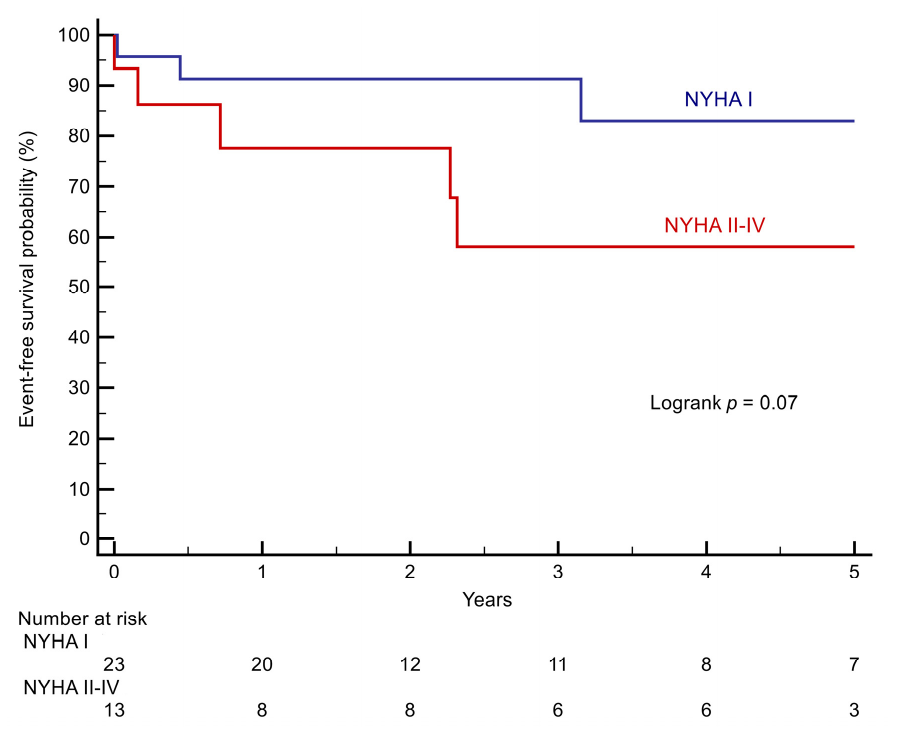
Figure 1. Kaplan–Meier curves stratifying patients according to NYHA class. The difference between patients with corrected vs. uncorrected cAVSD was not sta- tistically significant ( p = 0.14, Figure 2).